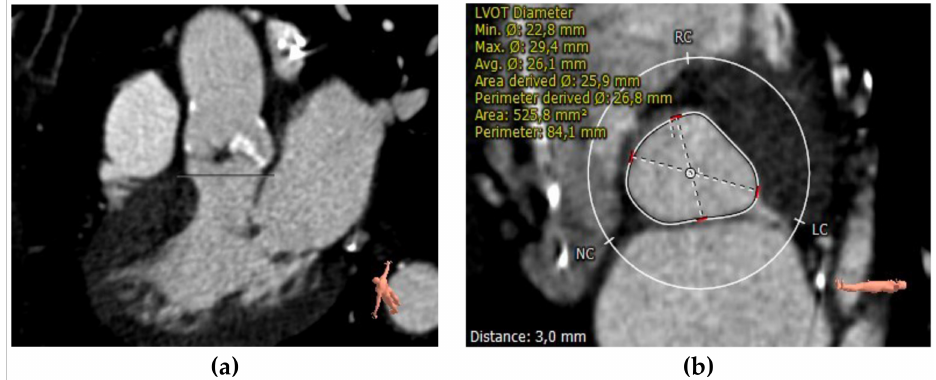
Figure 8. ( a ) LVOT calcium degree evaluation. ( b ) Preoperative LVOT